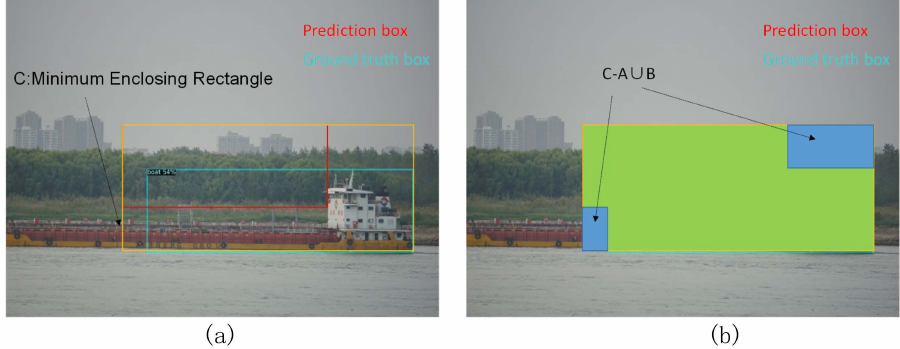
Figure 10. Schematic diagram of GIOU. ( a ) C is Minimum Enclosing Rectangle. ( b ) The areas of C-A ∪ B.